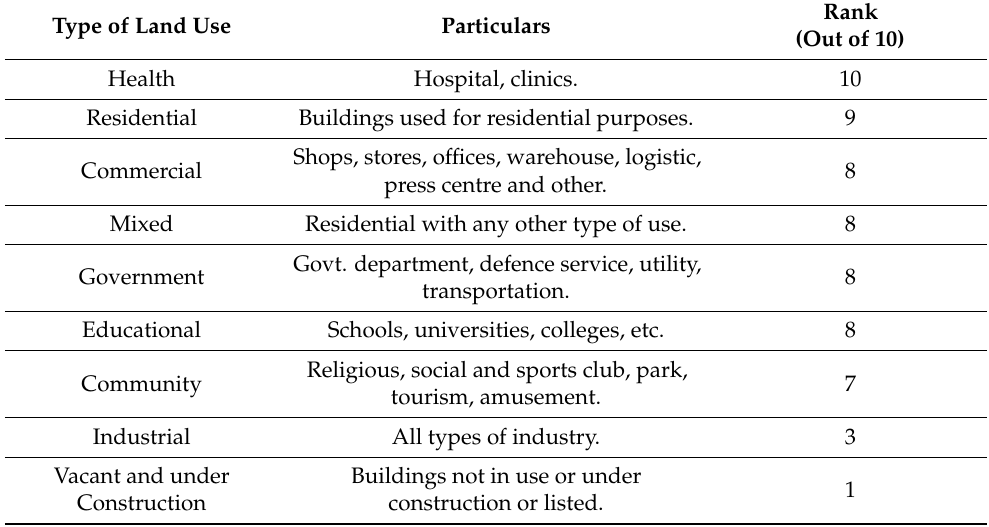
Table 9. Ranking of sub-class parameters—land use